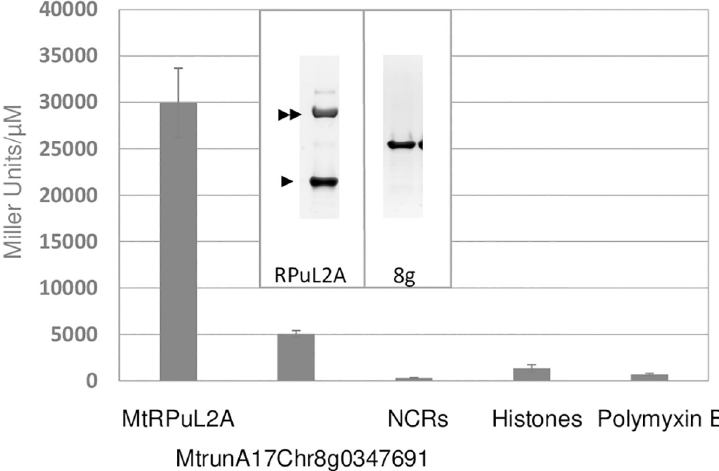
Fig 5. Specific activities of purified proteins and compounds. The insert shows SDS-PAGE images of purified protein preparations. The simple and double arrowheads point to the MtRPuL2A and the E . coli GroEL proteins, respectively. Activities for the MtRPuL2A and MtrunA17Chr8g0347691 proteins are the mean of two independent purification experiments. n = 3 for NCRs, histones and Polymyxin B. Error bars feature SE. Reporter strain is GMI12052 (wt).